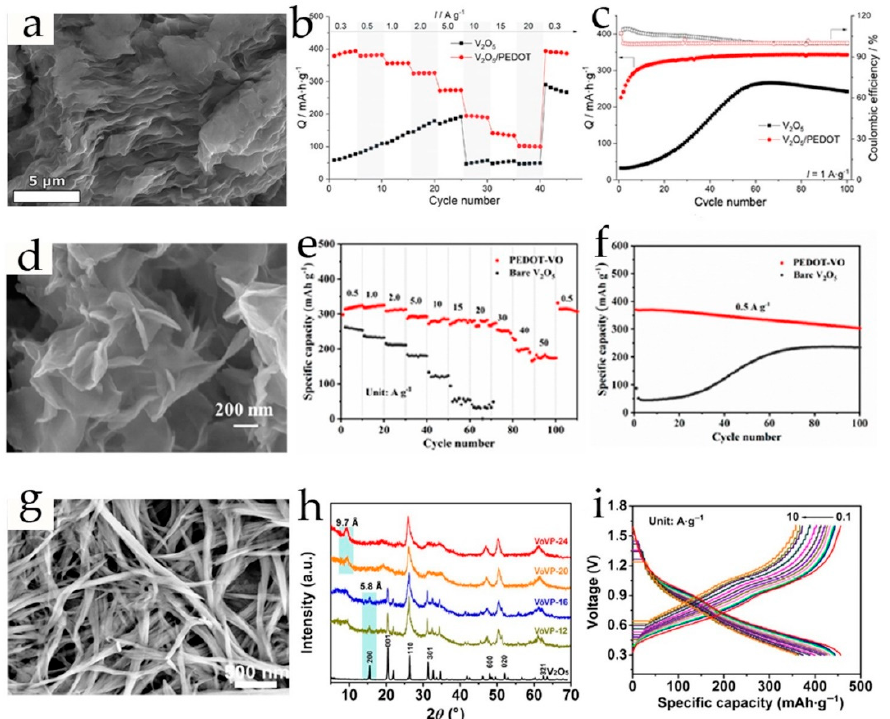
Figure 6. ( a ) SEM image of V 2 O 5 /PEDOT [95]; ( b ) C-rate capability of V 2 O 5 /PEDOT [95]; ( c ) Electrochemical performance of V 2 O 5 and V 2 O 5 /PEDOT electrodes: cycle performance and coulombic efficiency at 1 A g − 1 [95]; ( d ) Typical SEM images of PEDOT-VO [65]; ( e ) Rate performance of PEDOT-VO and V 2 O 5 electrodes at different current densities [65]; ( f ) Cycle performance of PEDOT-VO and V 2 O 5 electrodes at 0.5 A g − 1 [65]; ( g ) SEM of the as-prepared VöVP-20 [89]; ( h ) XRD patterns of VöVP-12, VöVP-16, VöVP-20, VöVP-24 and commercial V 2 O 5 [89]; ( i ) GCD curves of VöVP-20 at different rates [89].